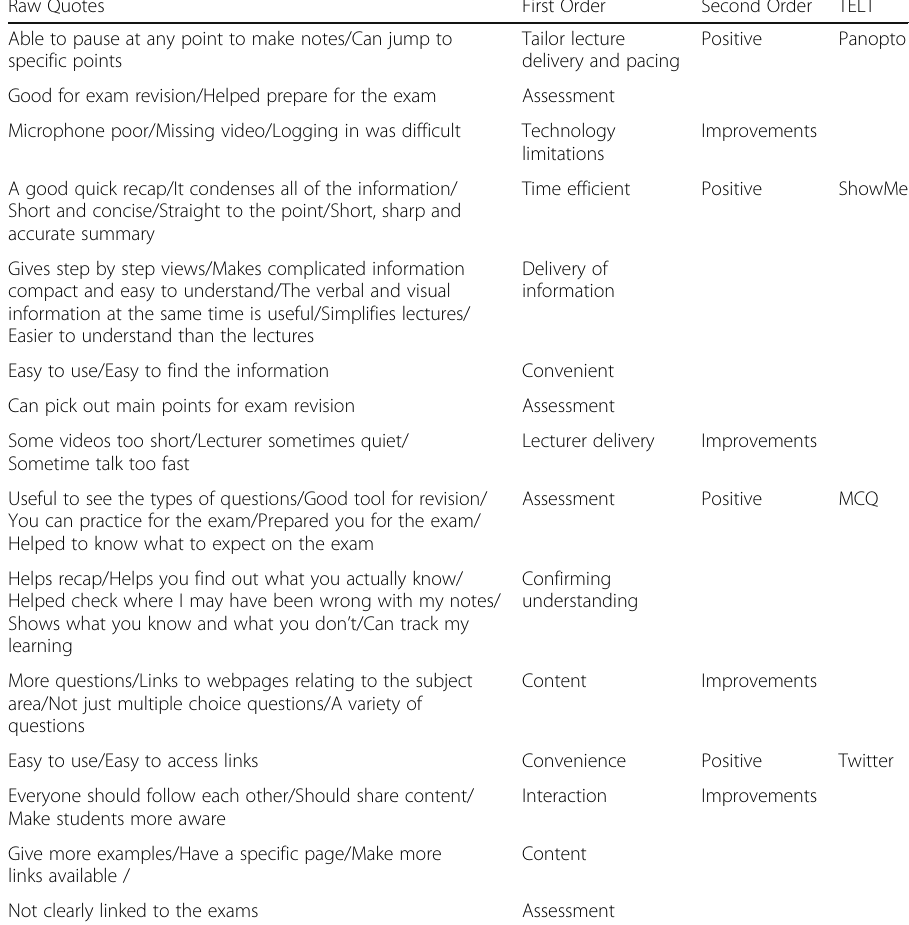
Table 4 Thematic analysis of qualitative responses for each TELT Raw Quotes First Order Second Order